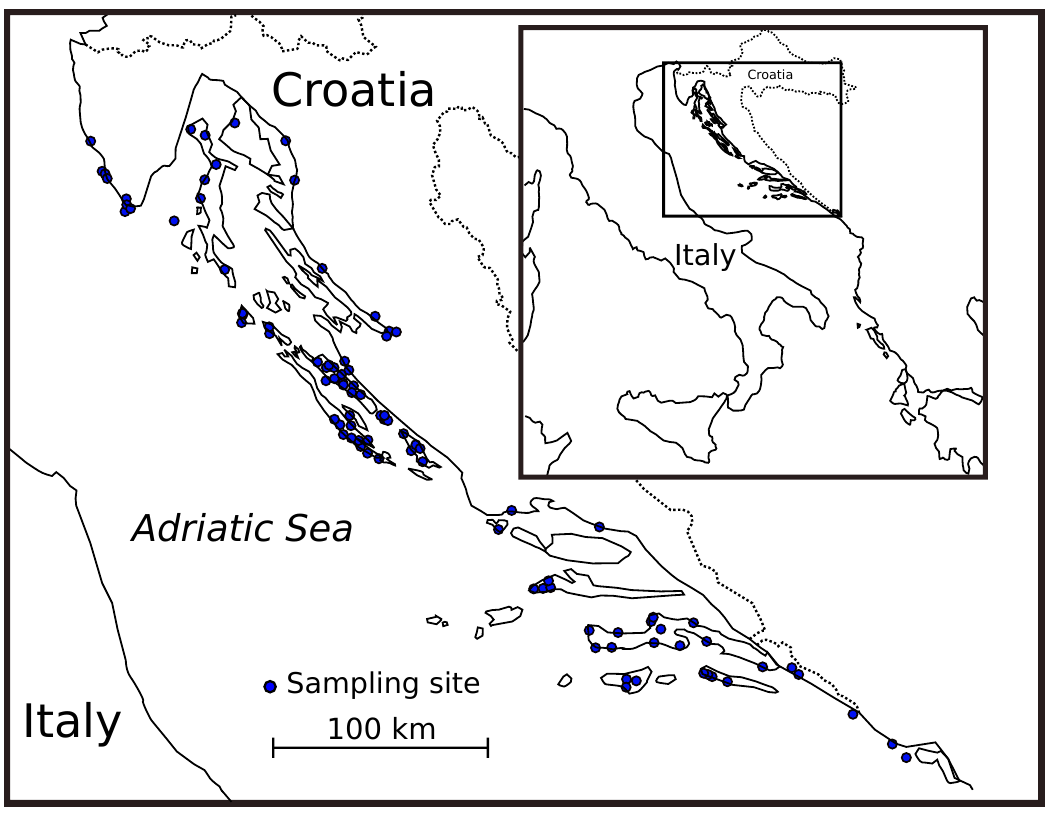
Figure 1. Sampling